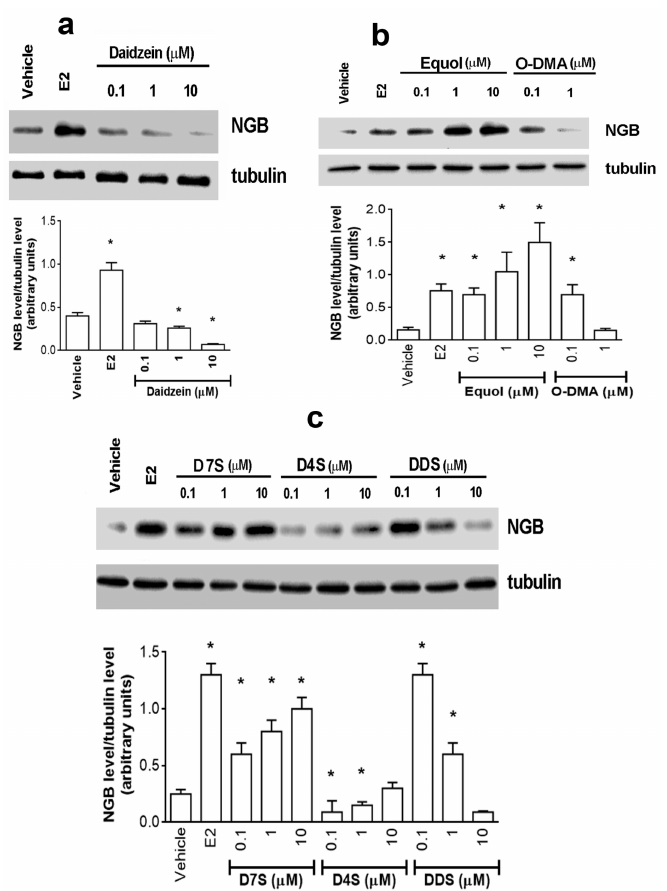
Figure 1. E ff ects of daidzein ( a ), equol and O-desmethylangolesin ( b ), daidzein-7-sulfate, daidzein-4 (cid:48) -sulfate and daidzein-7,4 (cid:48) -disulfate ( c ) on neuroglobin intracellular levels. ( a – c ) Western blot (top) and densitometric analyses (bottom) of NGB protein levels in MCF-7 cells treated for 24 h with the vehicle (DMSO), E2 (10 nM), D and its metabolites (0.1, 1.0, and 10 µ M). The amount of proteins was normalized by comparison with tubulin levels. Data are the mean ± SD of four di ff erent experiments. p < 0.001 was determined with Student t test with respect to the vehicle (*) treated samples. E2: estradiol; NGB: neuroglobin; DMSO: dimethyl sulfoxide; D: daidzein; Eq: equol; O-DMA: O-desmethylangolesin; D7S: daidzein-7-sulfate; D4S: daidzein-4 (cid:48) -sulfate; DDS: daidzein-7,4 (cid:48)